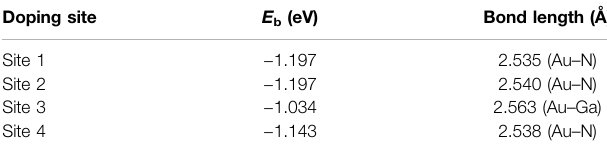
TABLE 1 | Bond length and binding energies of the four different doping sites. Doping